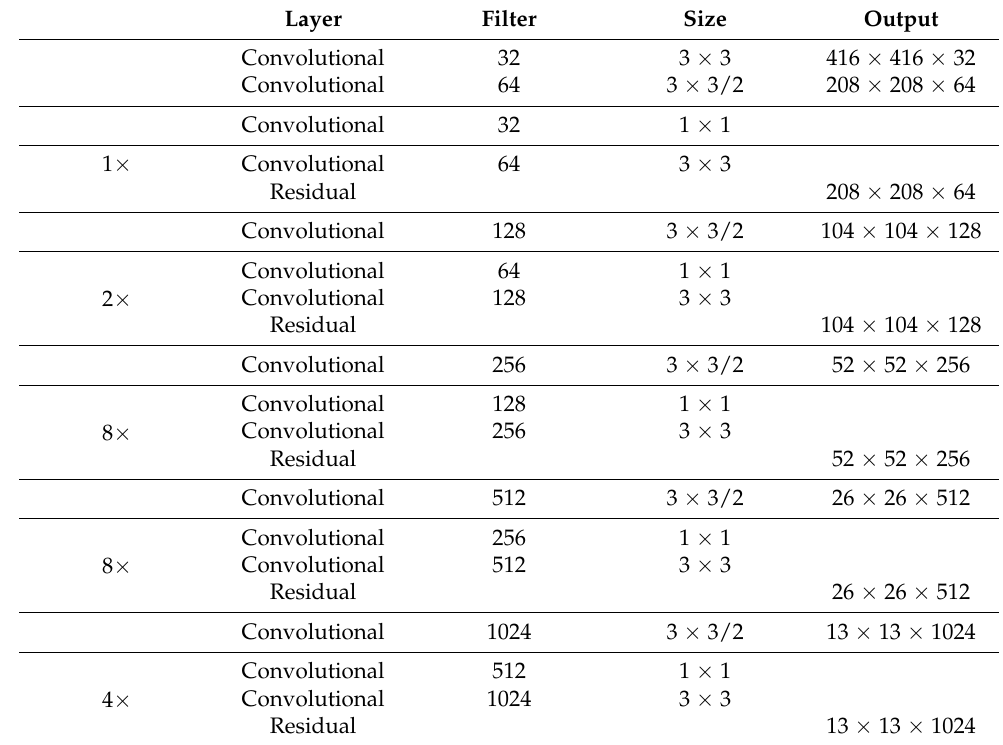
The loss function of YOLO-V3 can be divided into three parts: (1) coordinate prediction error, (2) IOU (Intersection over Union) error and (3) classification